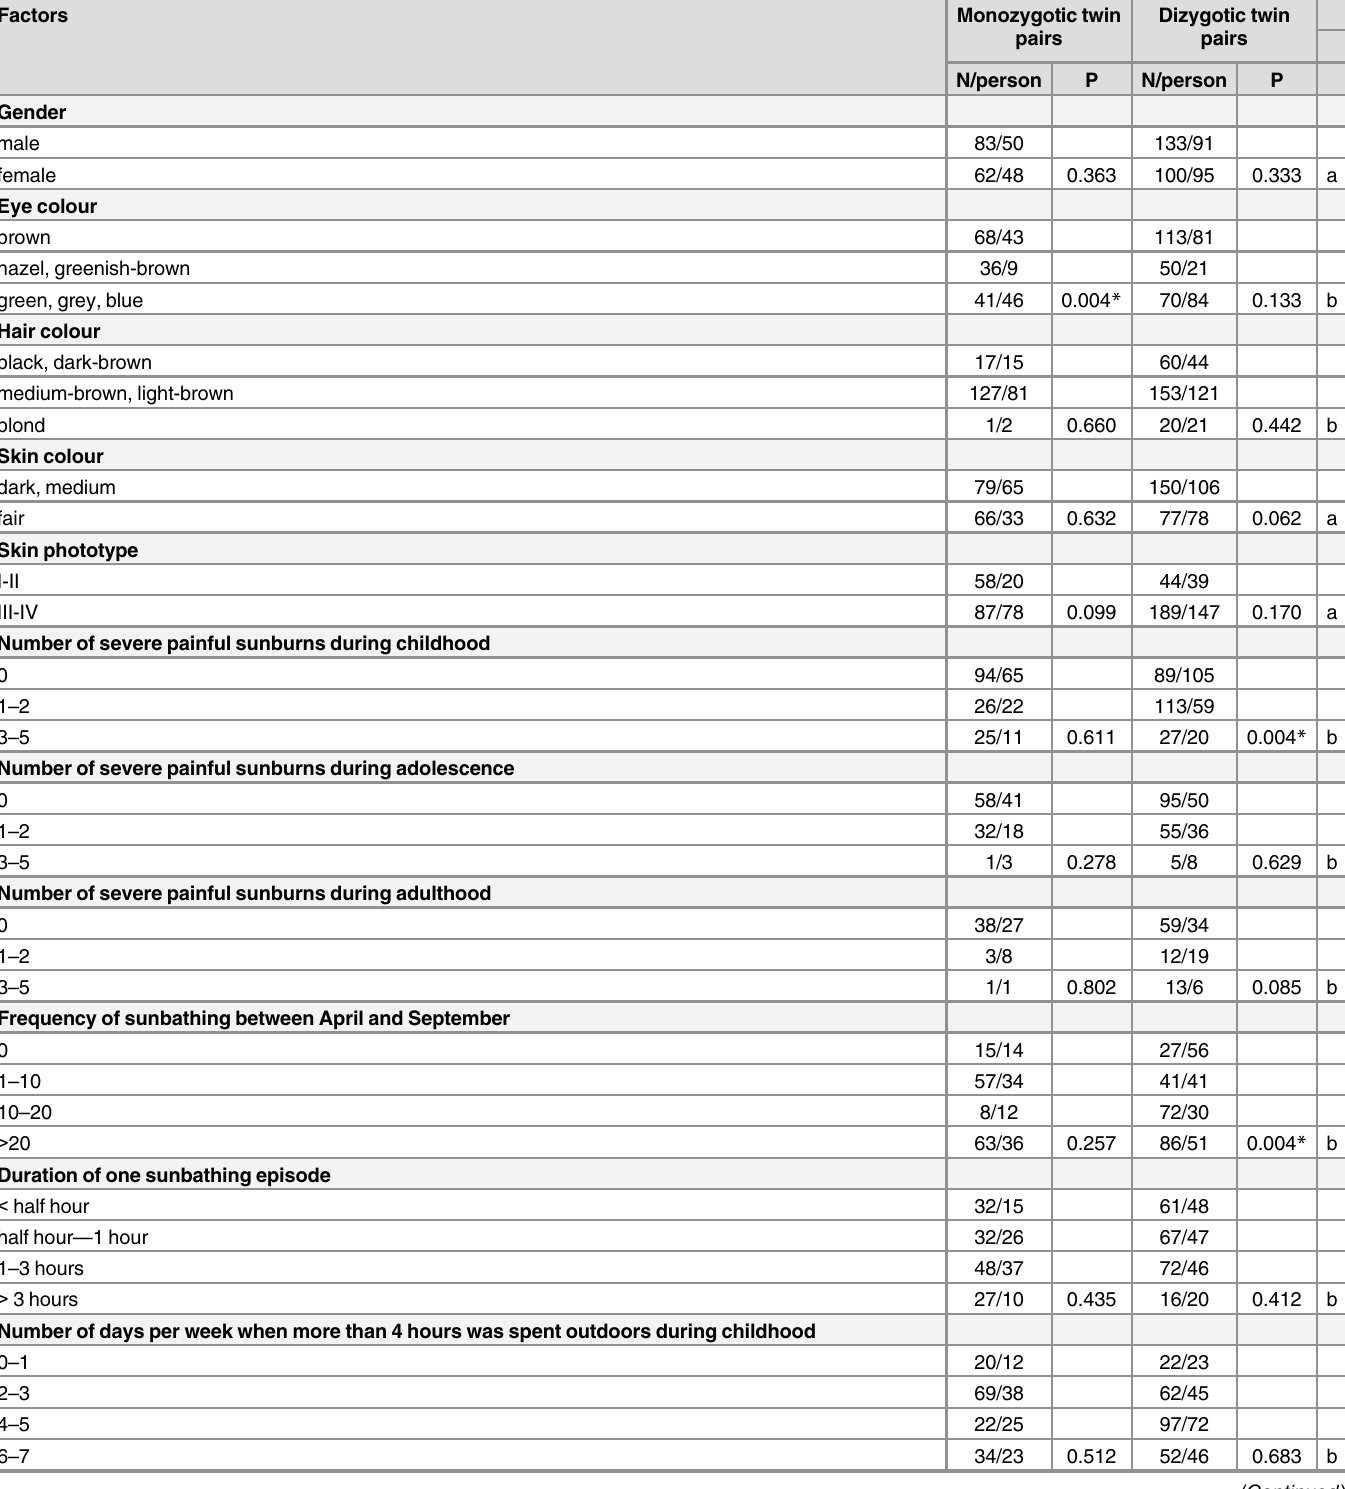
Table 5. Association between gender, constitutional and sun exposure variables and the prevalence of benign ocular pigmented lesions among monozygotic (98 persons) and dizygotic (186 persons) twin